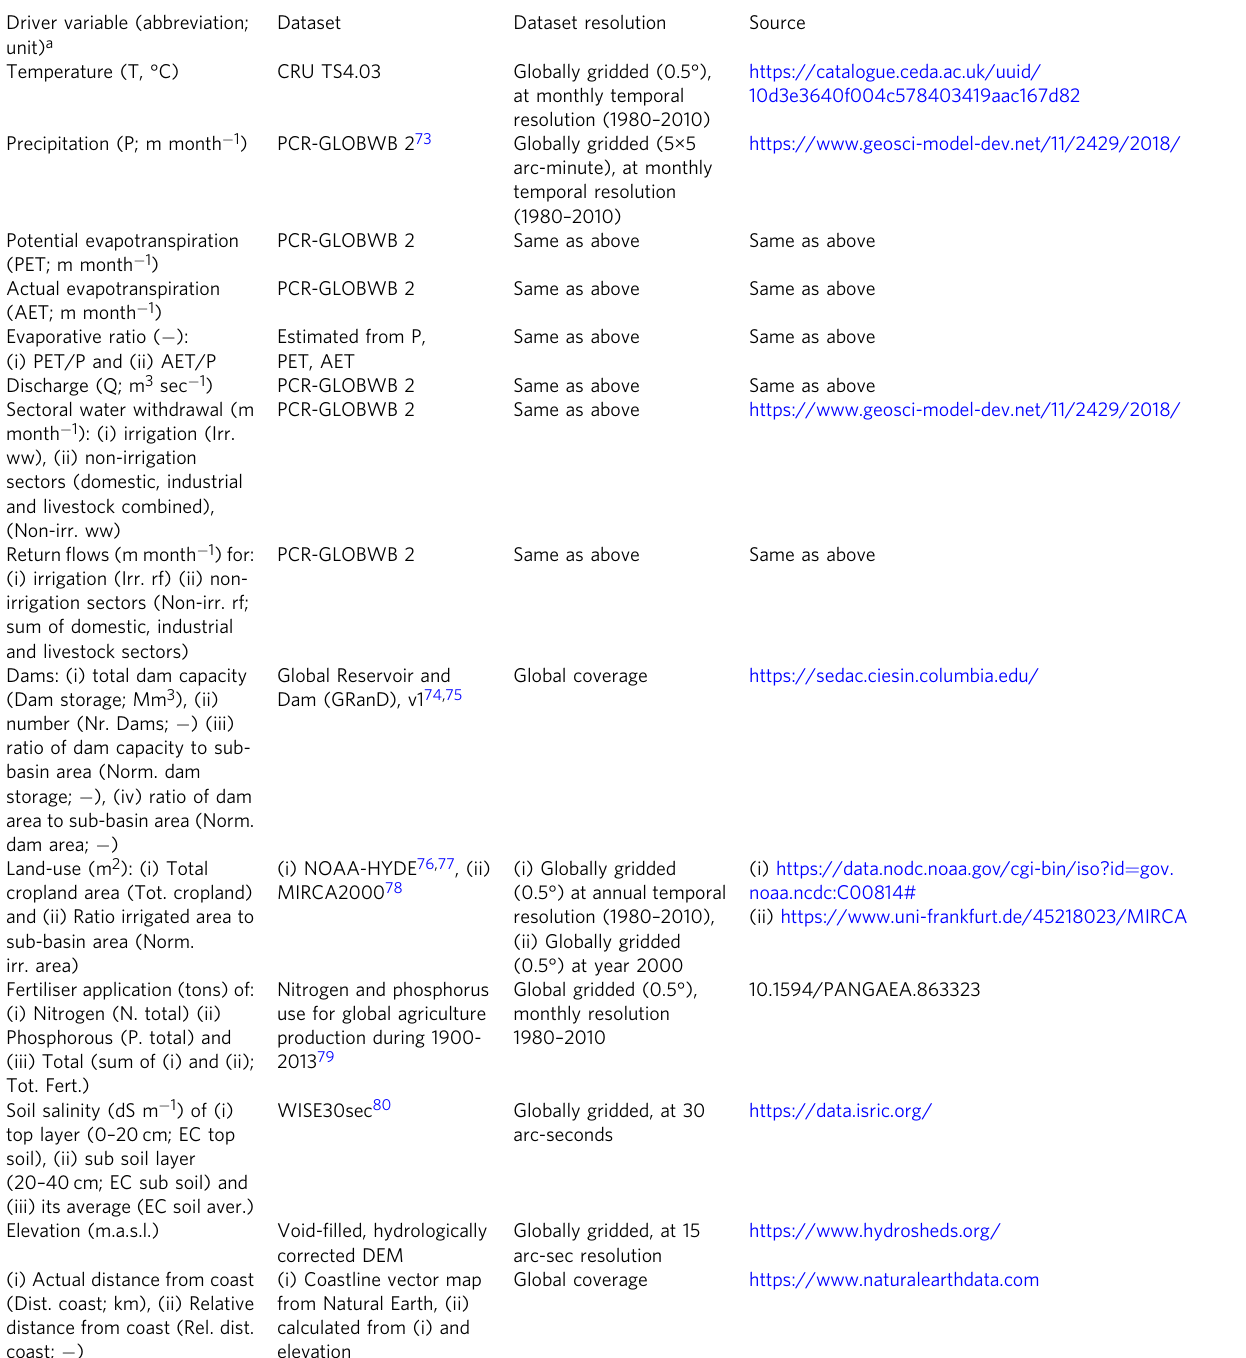
Table 1 Information on all main driver variable groups and their respectively sub-categories included in this study. Driver variable (abbreviation; unit)